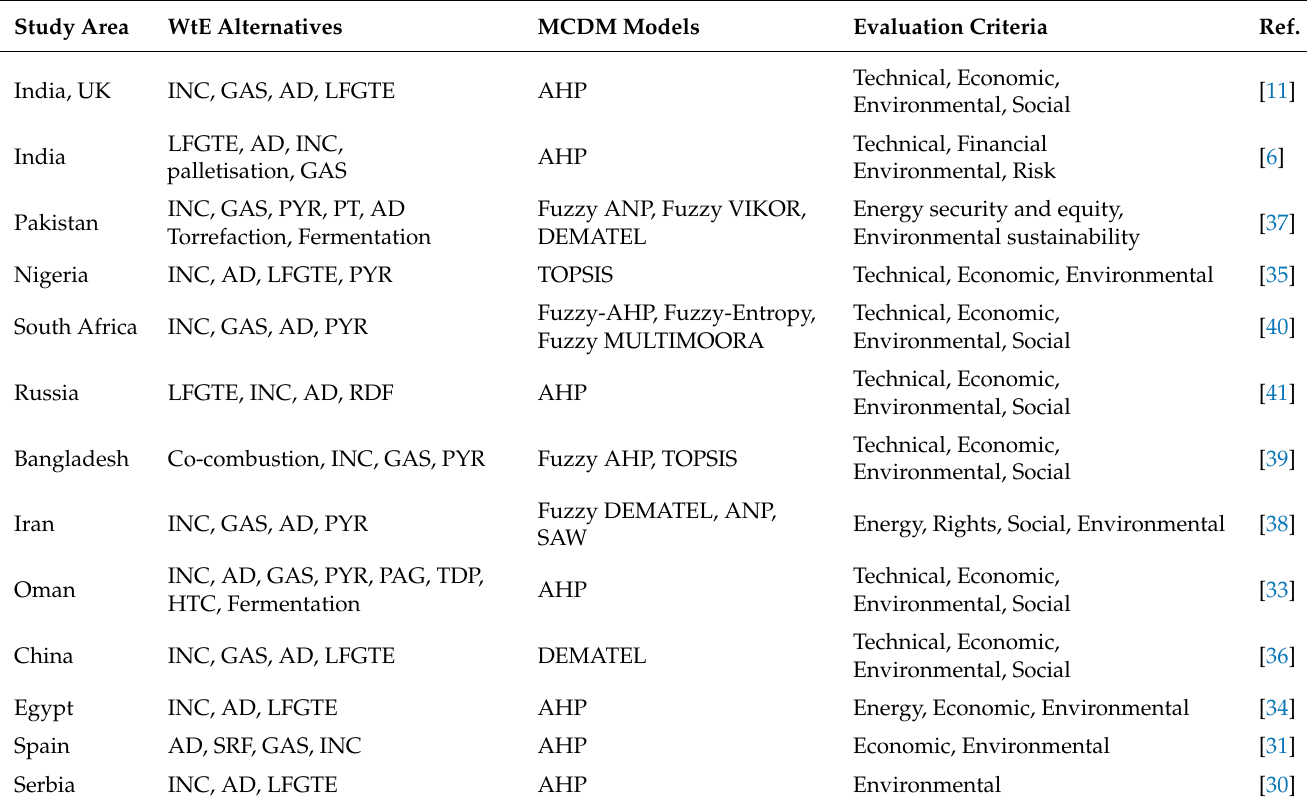
Table 2. MCDM models applied to WtE-related studies in various